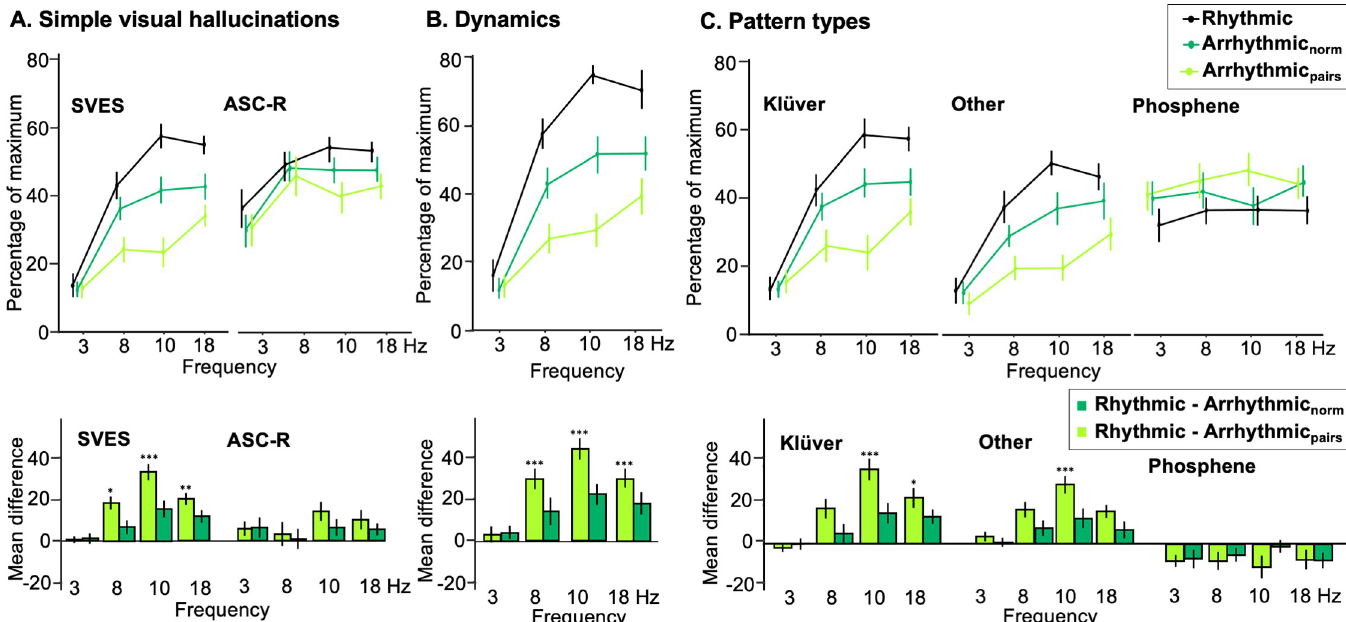
Fig 2. Differential effects of rhythmicity and frequency on FLS-induced hallucinatory phenomena. (A) Effects of rhythmicity and frequency on reports of simple visual hallucinations. Ratings are shown from the SVES Simple Visual Hallucinations and ASC-R Elementary Imagery scales. (B) Effects of rhythmicity and frequency on visual dynamics, which encompasses motion and how much the experience changes over time. (C) Effects of rhythmicity and frequency on different types of visual patterns. Klüver forms SVES subscale consists of spirals, cobwebs, targets and grids. Other forms include SVES items of rippling items and flowing lines. Phosphene forms refers to lower order forms and includes SVES items for TV snow and blobs of light or colour. Bar charts display the difference in ratings between arrhythmic controls and rhythmic stimulation for each frequency. Significance is determined by Tukey tests comparing ratings between rhythmicity conditions at each frequency level [See S1 Table for Tukey test